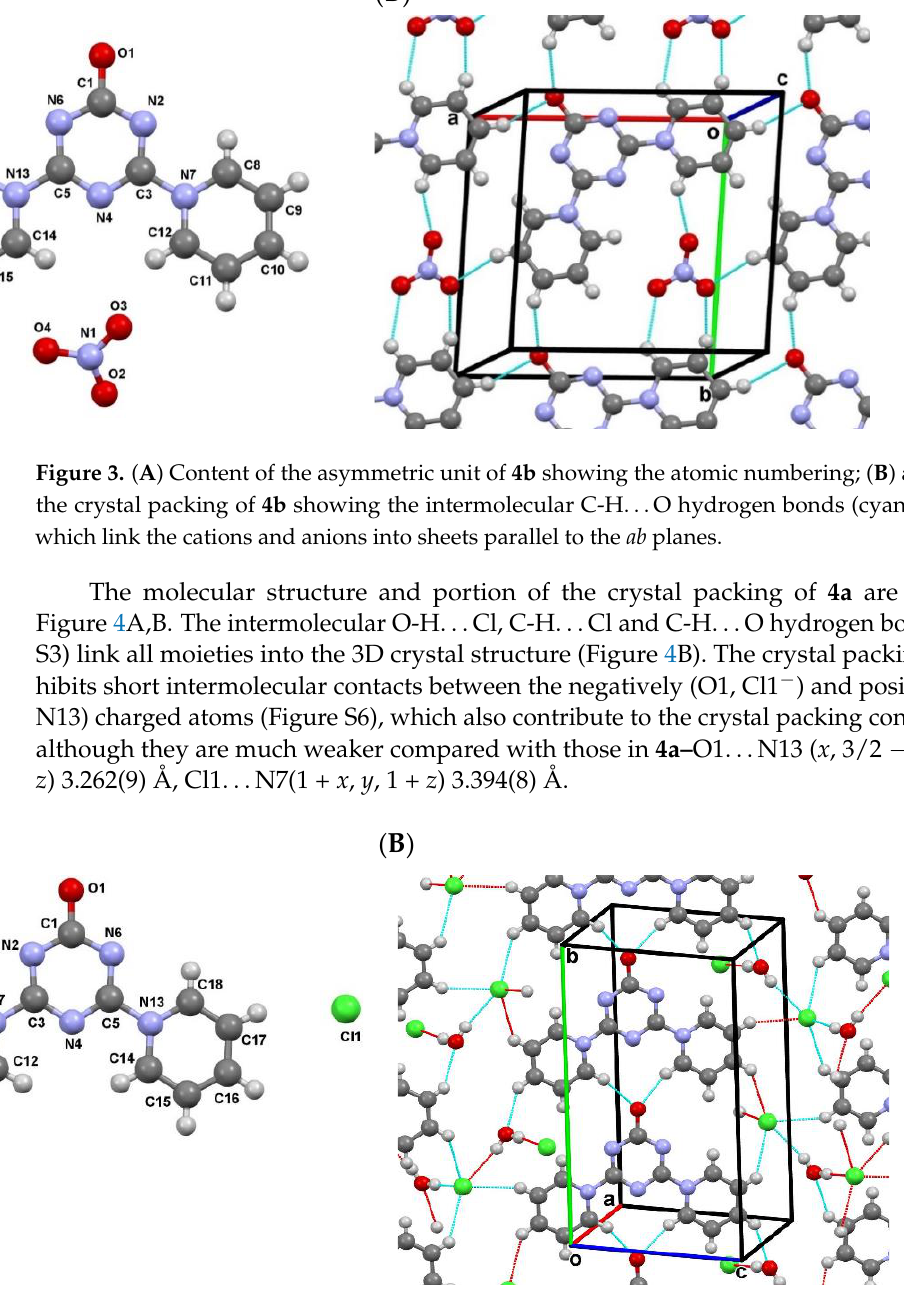
Figure 4. ( A ) Content of the asymmetric unit of 4a showing the atomic numbering; ( B ) crystal packing of 4a showing the intermolecular O-H. . . Cl, C-H. . . Cl and C-H. . . O hydrogen bonds as thin cyan and red lines.